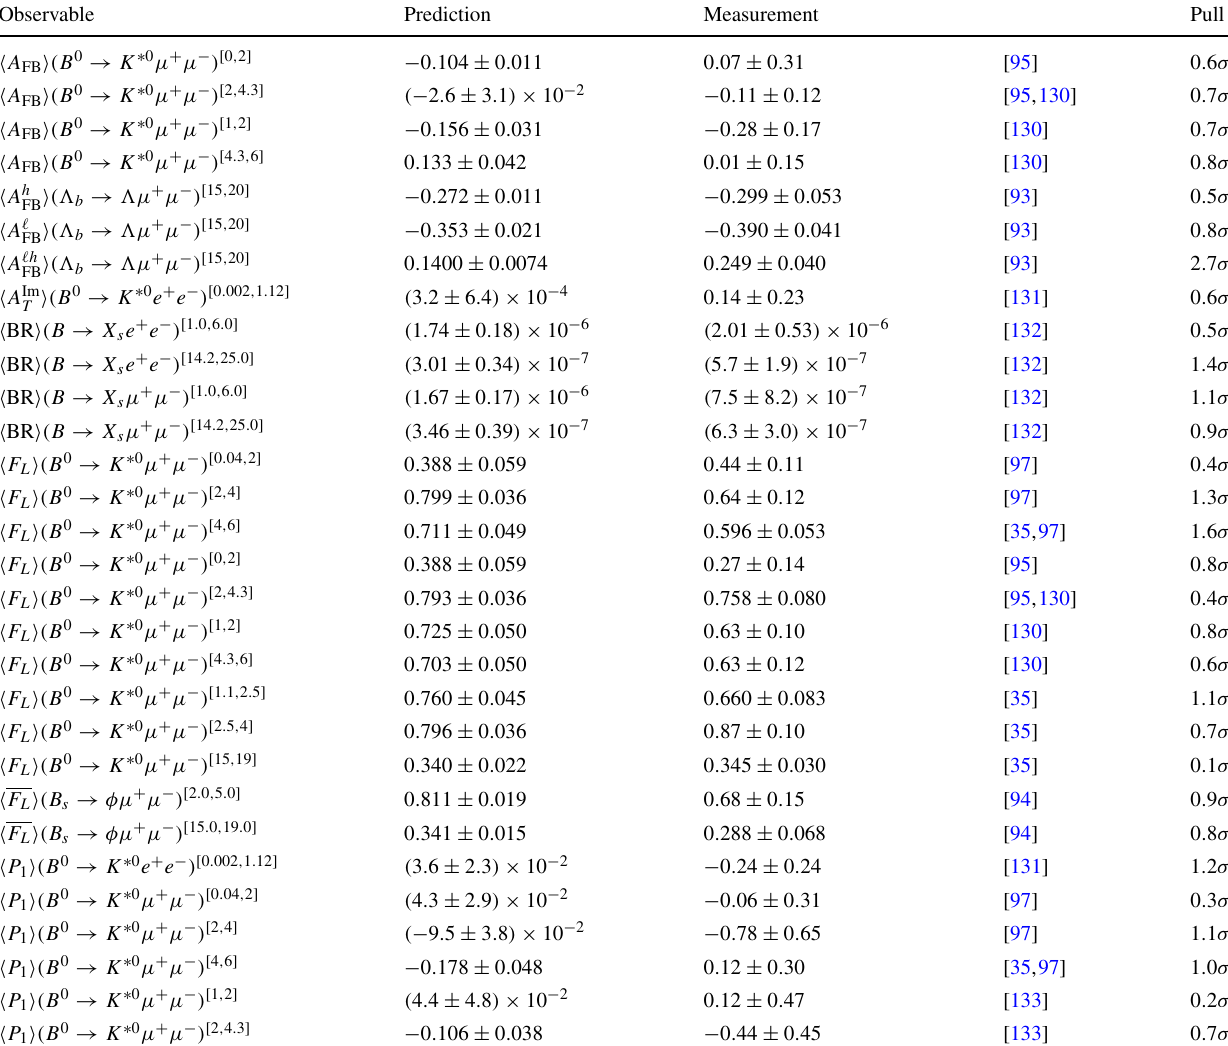
Table 2 Quark flavour observables where theory uncertainties are taken into account Observable Prediction